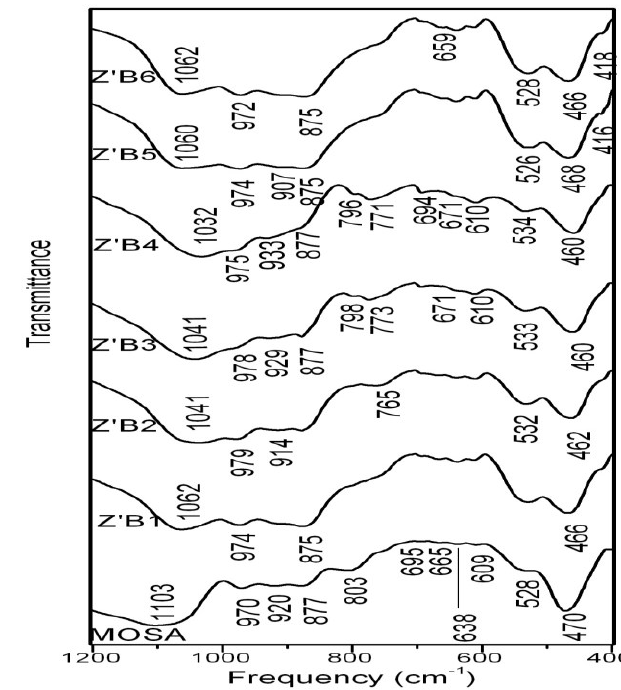
Figure 6. FTIR of the activated